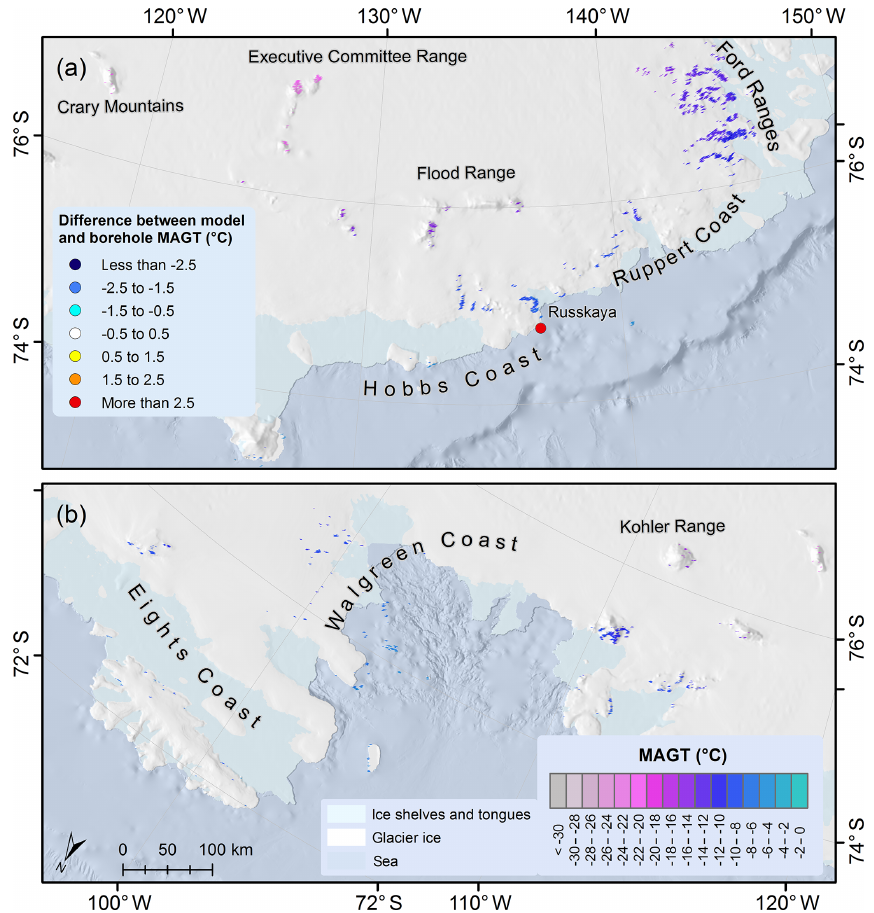
Figure 11. Permafrost temperature maps of Marie Byrd Land and differences between borehole and modelled MAGT. Legends, scale and north arrow are valid for both panels. See Fig. 1 for location of panels (a) and (b)